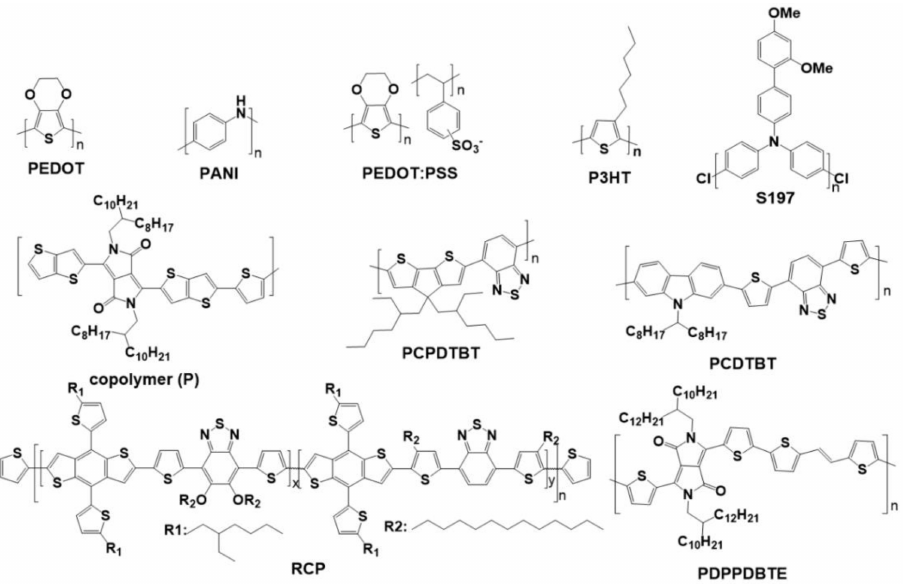
Figure 12. Chemical structures of polymers used to discuss the hole transport